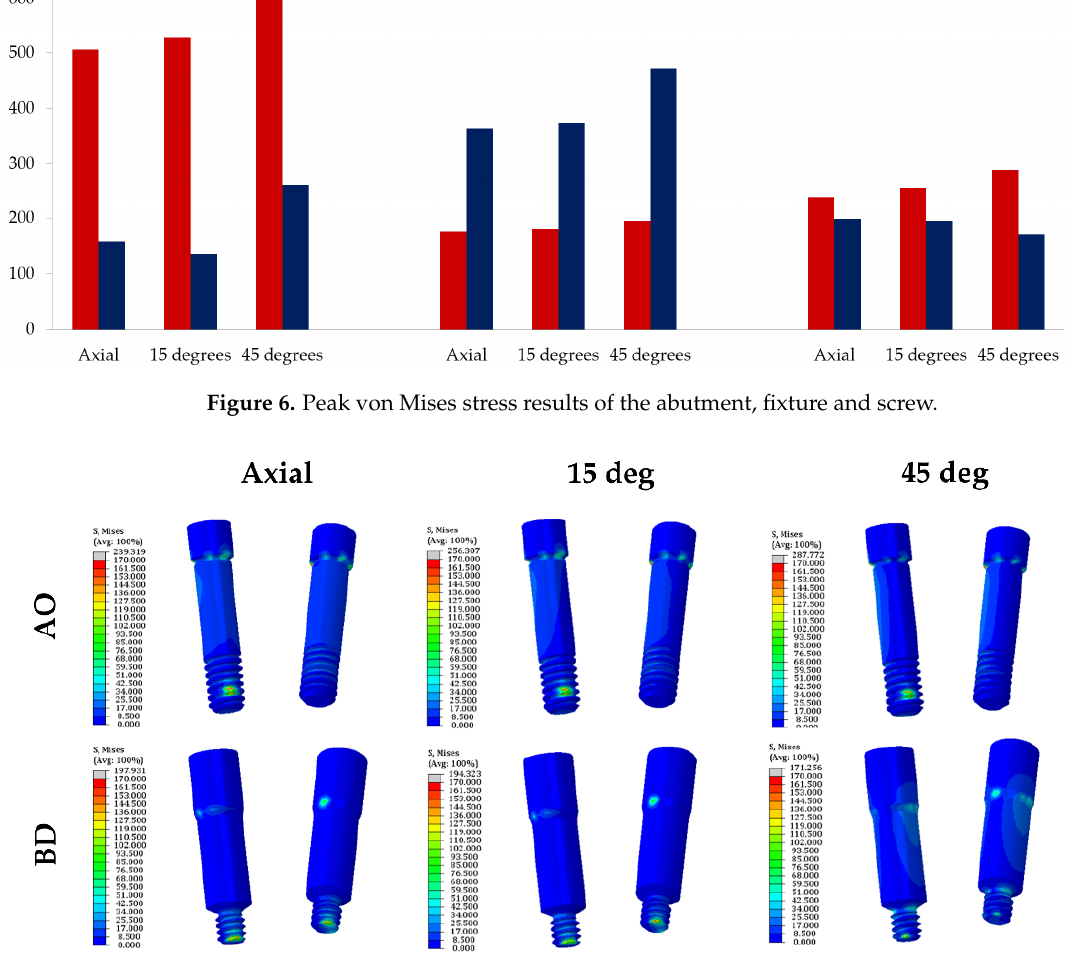
Figure 8. Maximal principal stress (MPa) results from cortical bone, cancellous bone, and crown . 3.3. Stress on the Inner Surface of the Abutment and Fixture Stress was derived from the surface in contact with the abutment and fixture since they were combined and measured in two areas of the second premolar and second molar, respectively. The average stress on the outer surface of the abutment was lower in the AO group than in the BD group under all load conditions (Figure 9 and Table S2) (Figure 10) (Figure 11). These findings confirmed that the BD group presented a better stress distri- bution than the AO group under the axial and 15° load in the stress distribution for the inner surface of the fixture. However, the average stress of the BD group at the 45° load was 1.5 times higher than the AO group.